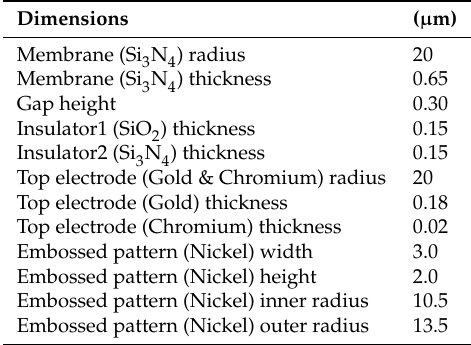
Table 1. Design parameters of the embossed